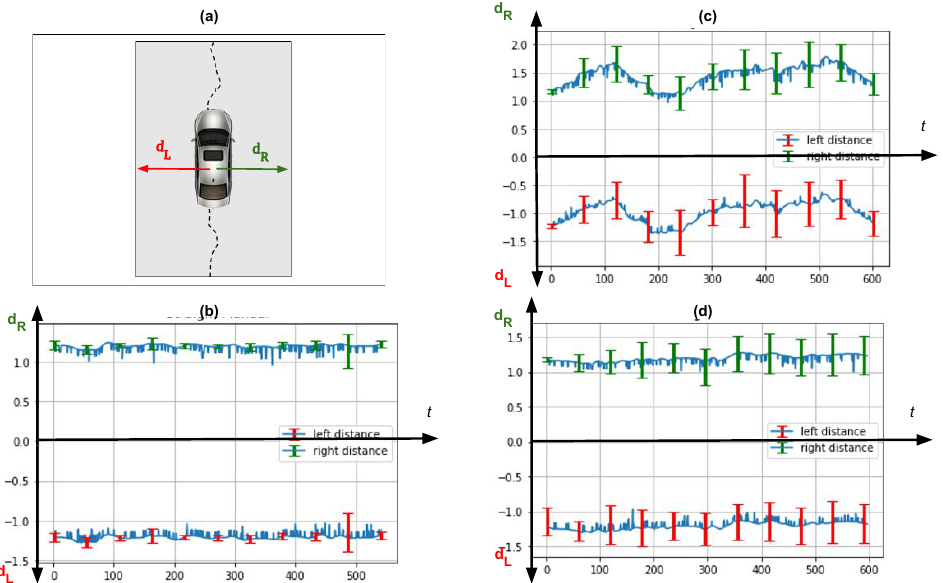
Figure 24. Straight path performance test curves with error bars. Green error bars are related to the distance between the right wall and the center of the vehicle. Red error bars are related to the distance between the left wall and the center of the vehicle. ( a ) Straight path. ( b ) Driving by a human operator. ( c ) Driving by the neural network trained with camera images. ( d ) Driving by the neural network trained with LiDAR.